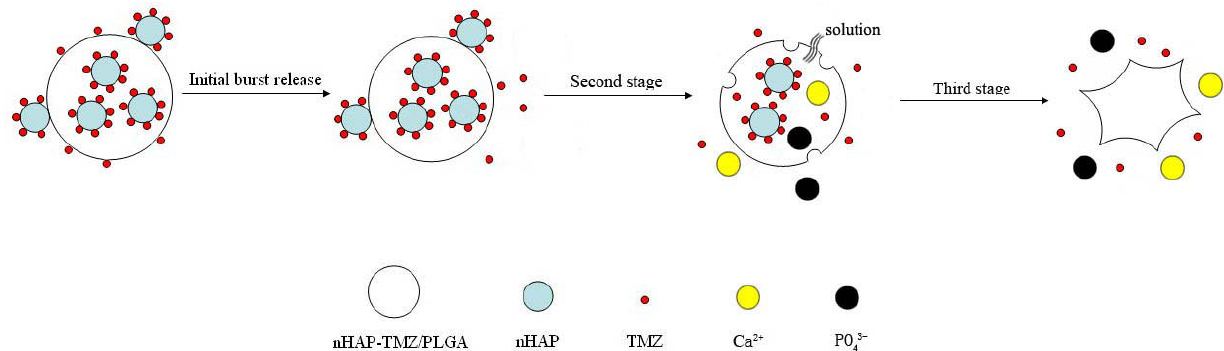
Figure 5. The schematic diagram of entire release